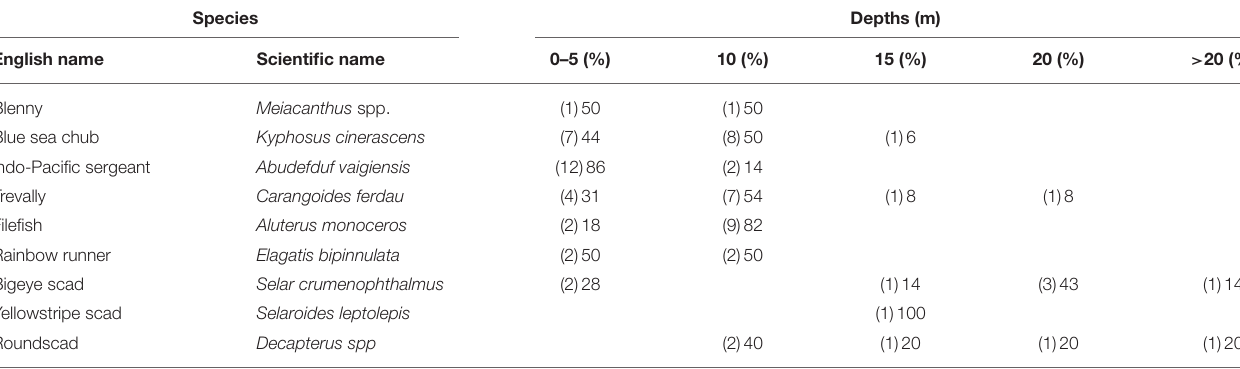
TABLE 5 | Presence of various fish species at different depths found in 10 anchored FADs examined in Davao Gulf, Philippines. Species Depths